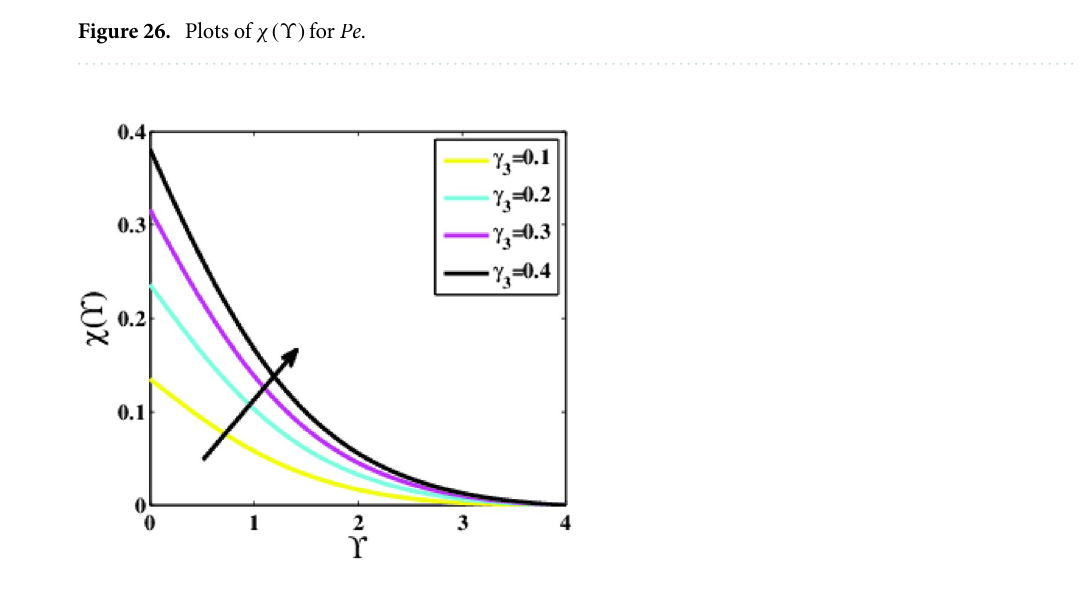
Figure 27. Plots of χ(ϒ) for γ 3 .